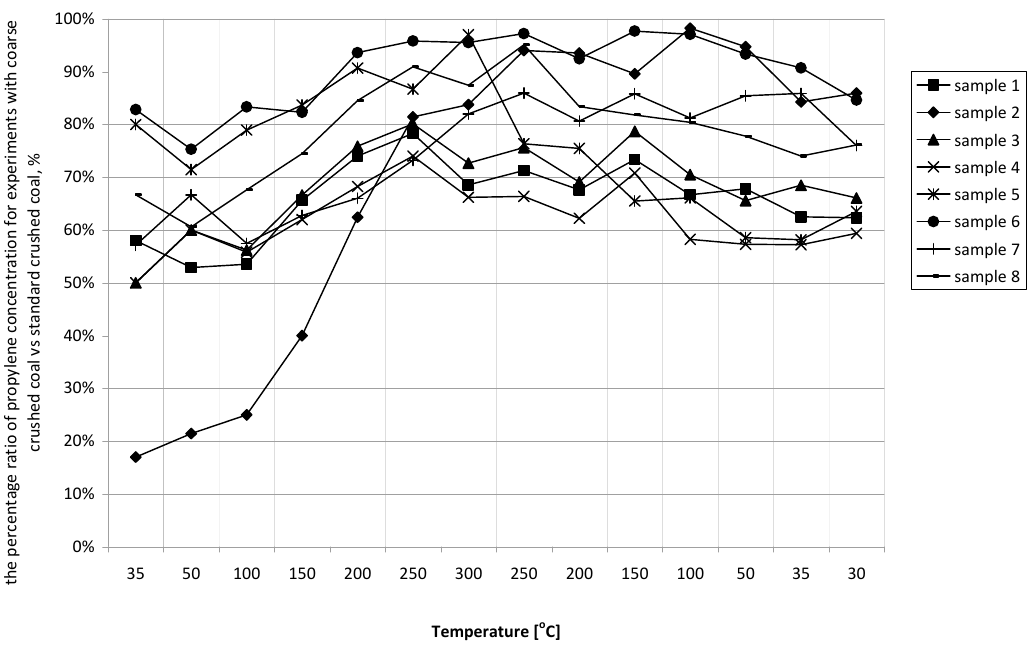
Figure 6. The course of changes in the ratio of released propylene (for both coarse and standard crushing) in the stages of heating and cooling of coal samples.